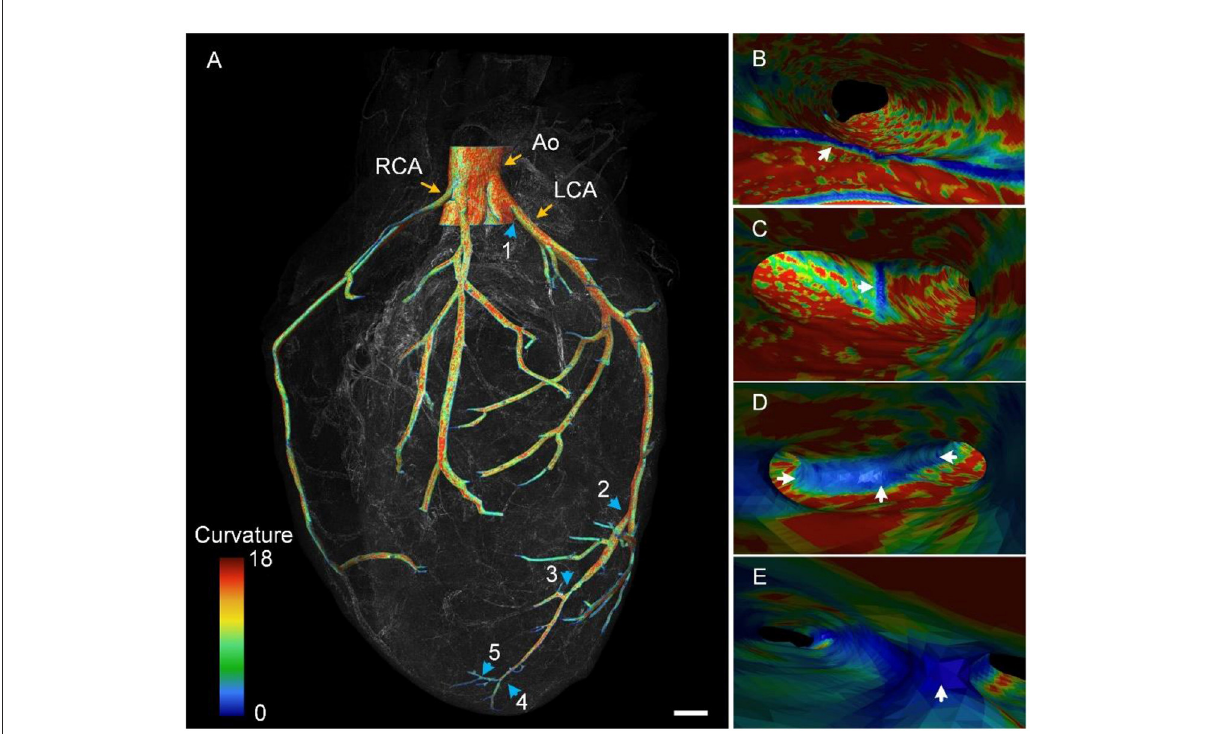
FIGURE5 Color-coded vascular network based on the curvature of the vascular wall. (A) The 3D rendering of the reconstructed vascular network. Blue arrows point out five branches along the LCA. Ao, aorta; LCA, left coronary artery; RCA, right coronary artery. (B–E) Endoscopic perspective of corresponding branches 1–4 in (A) with colors representing the curvature difference. (B) is the division of the Ao and LCA.